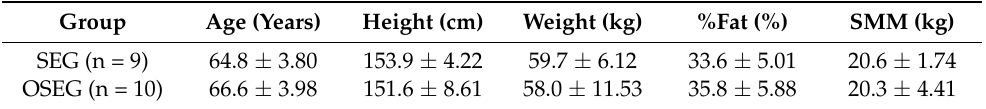
Table 1. Physical characteristics of subjects.